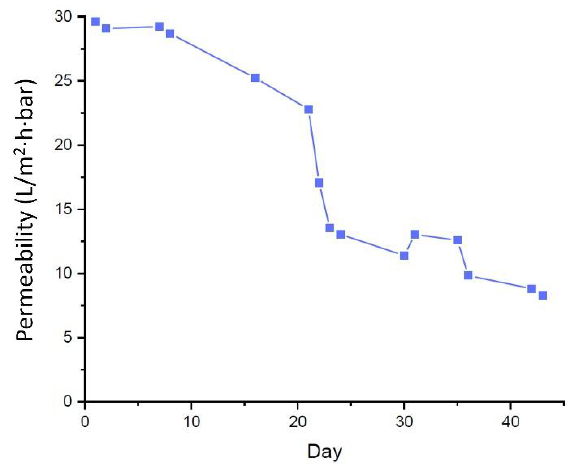
Figure 4. Permeability evaluation on membrane system in IFASM over long-term operation run using reactor A (of 0.22 m) at an initial TS concentration of 5.5 g/L.